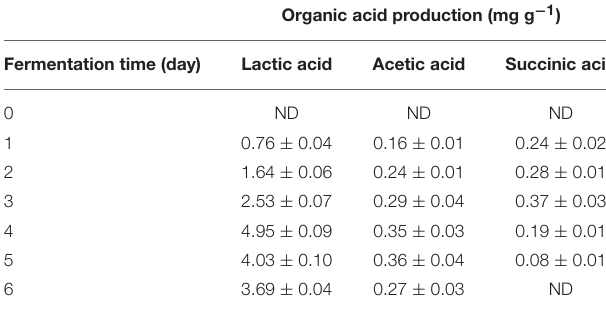
TABLE 5 | Organic acids production by the action of Lactobacillus plantarum L7 during the course of